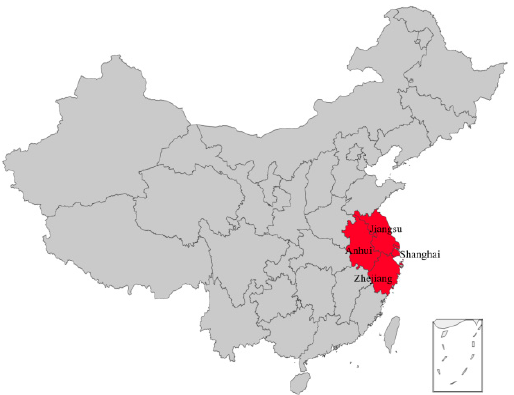
Figure 1. Yangtze River Delta map.